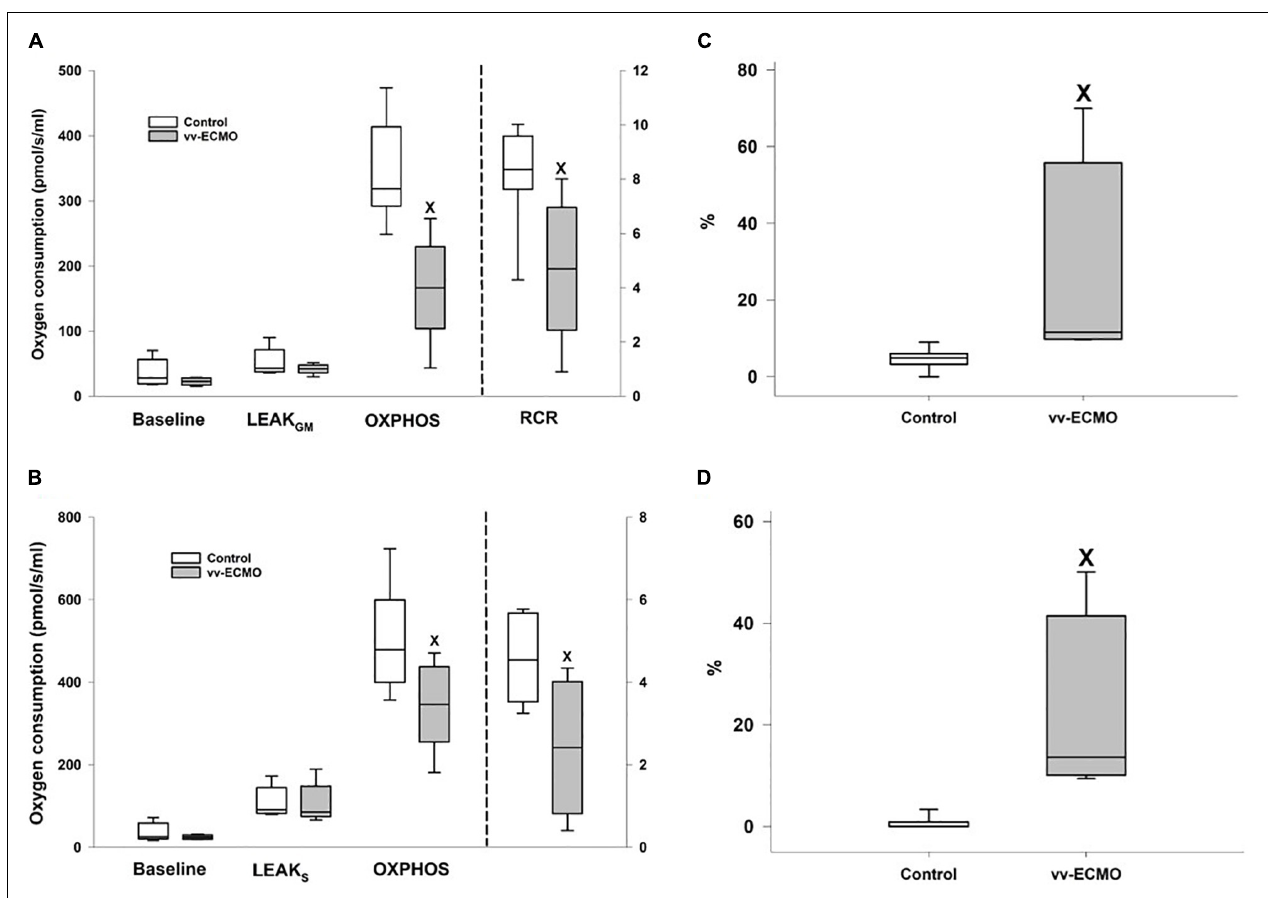
FIGURE 7 | Changes in baseline and LEAK GM respirations, complex I-linked oxidative phosphorylation capacities (OXPHOS; left axis) and respiratory acceptor control ratios (RCR; right axis) in the control (empty box) and vv-ECMO (gray box) groups (A) . Changes in baseline and LEAK S respirations, complex II-linked oxidative phosphorylation capacities (OXPHOS; left axis) and respiratory acceptor control ratios (RCR; right axis) in the control (empty box) and vv-ECMO (gray box) groups (B) . Changes in the complex I-linked (C) and complex II-linked (D) oxygen flux following addition of cytochrome c in the control (empty box) and vv-ECMO (gray box) groups. The plots demonstrate the median (horizontal line in the box), the 25th and 75th percentiles, and the range of data (whiskers). x P < 0.05 for the vv-ECMO vs. control group values (Mann–Whitney